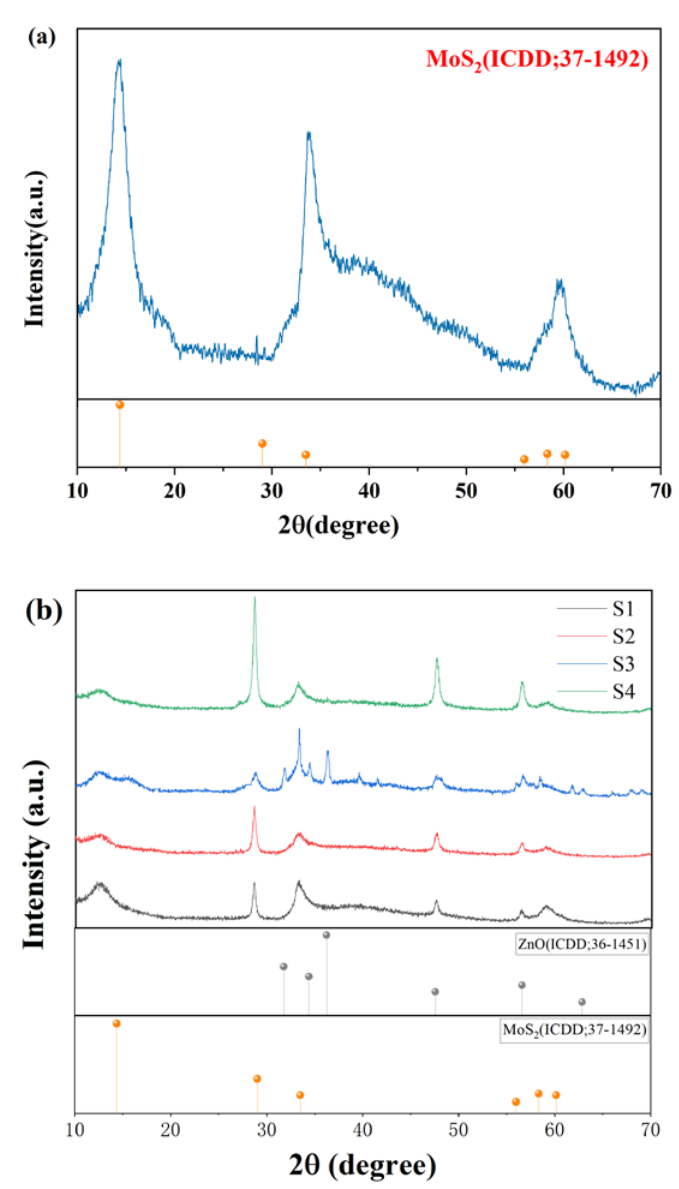
Figure 4. ( a ) X-ray diffraction (XRD) data of MoS 2 and ( b ) ZnO-MoS 2 with different composite ratios.